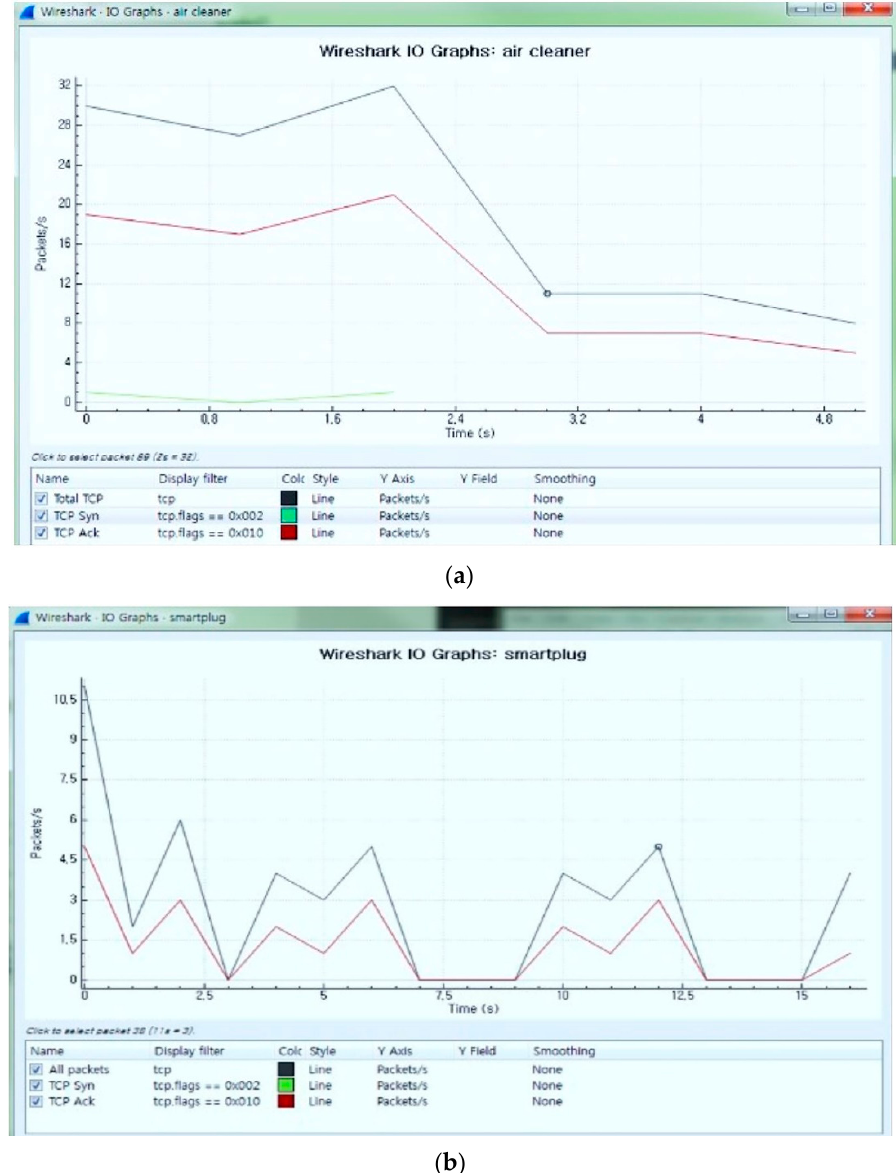
Figure 6. Experiments on M2M intelligent network device packet and operation ( a ) Air Cleaner, ( b ) 220v Plugin.